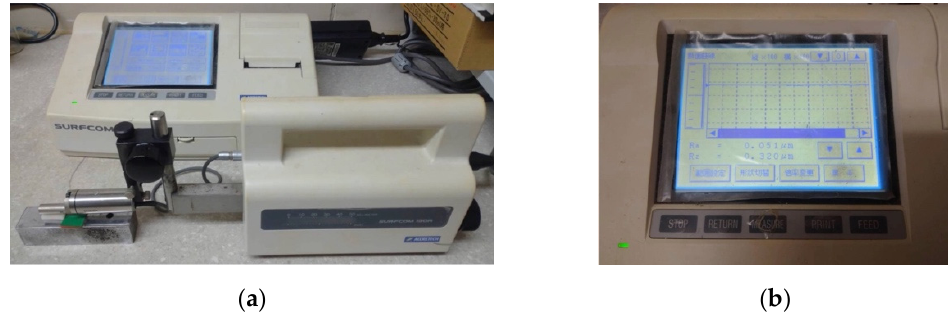
Figure 4. ( a ) Handheld glossiness meter and ( b ) its measurement screen.